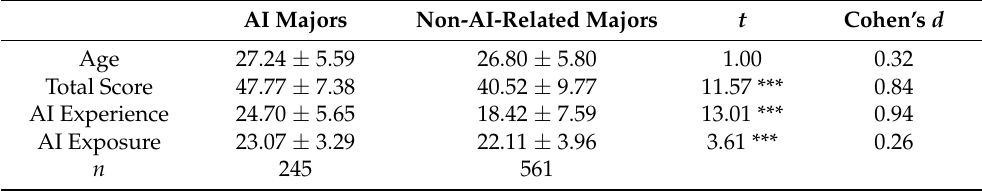
Table 2. AI Experience Questionnaire scores for AI majors and non-AI-related majors, Study